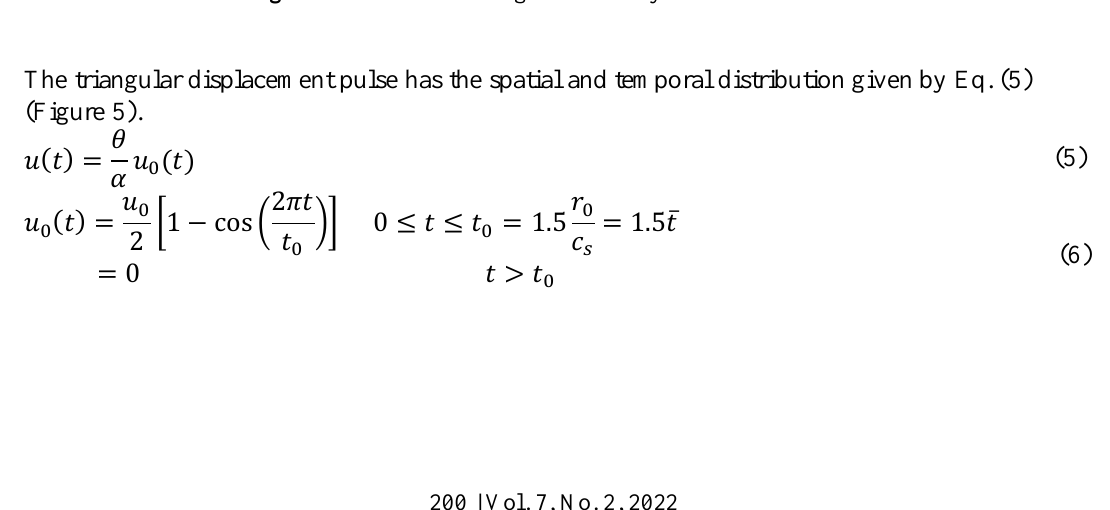
Figure 4. Semi- infinite segmental cavity in